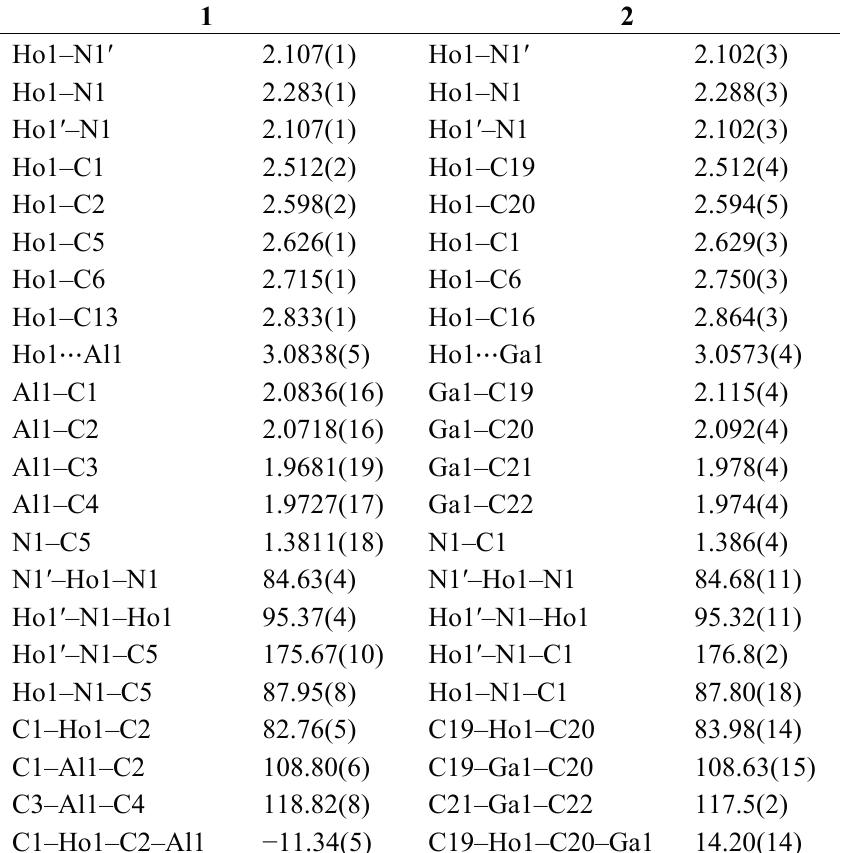
Table 1. Selected bond lengths [Å] and angles [°] of complexes 1 and 2 .